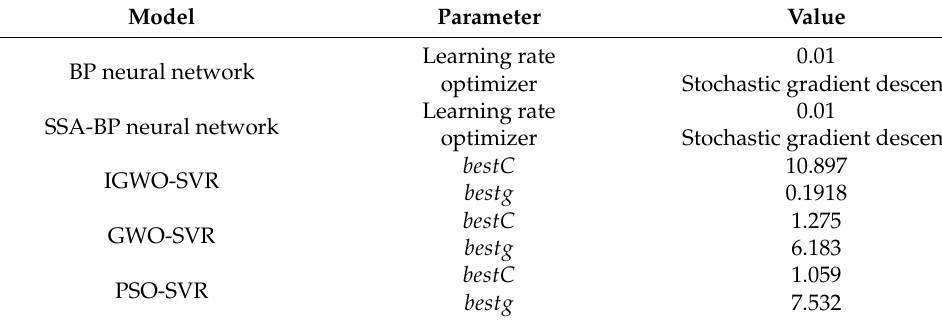
Table 6. Parameter values for different rotation error prediction